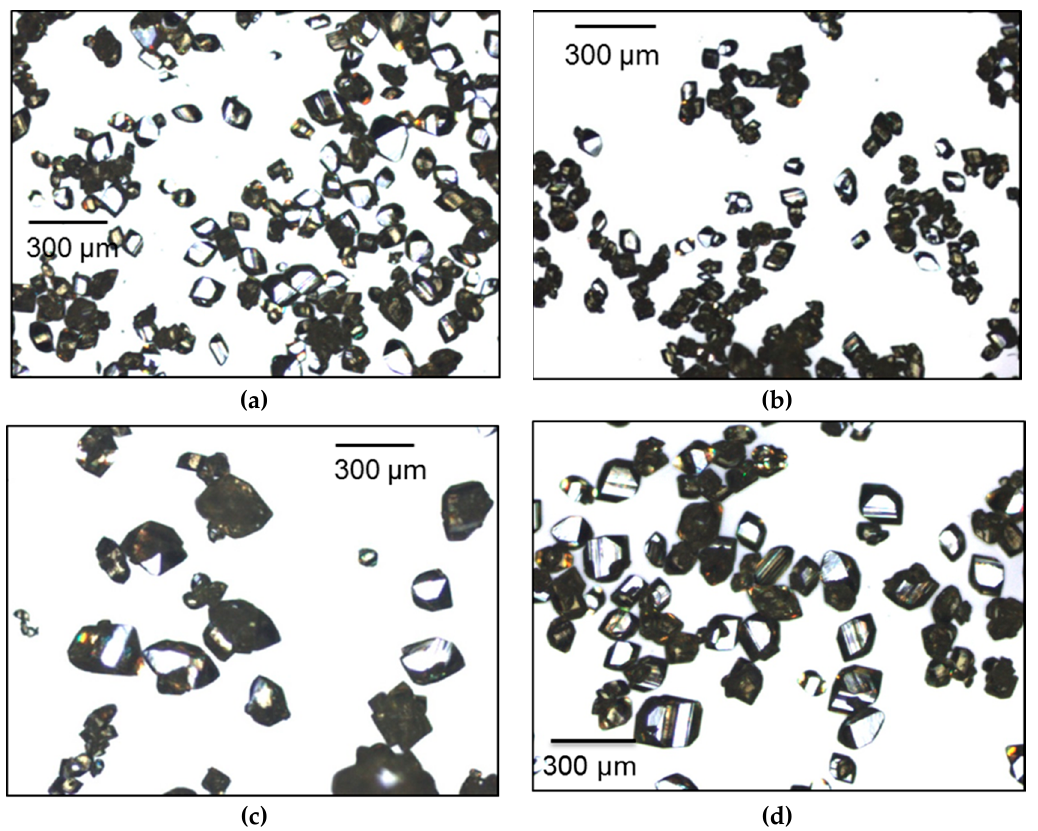
Figure 9. Microscopic images of crystals grown from: ( a ) membrane seeds (2% of the total mass of piroxicam); ( b ) membrane seeds (6% of the total mass of piroxicam); ( c ) antisolvent seeds; ( d ) transformation seeds.